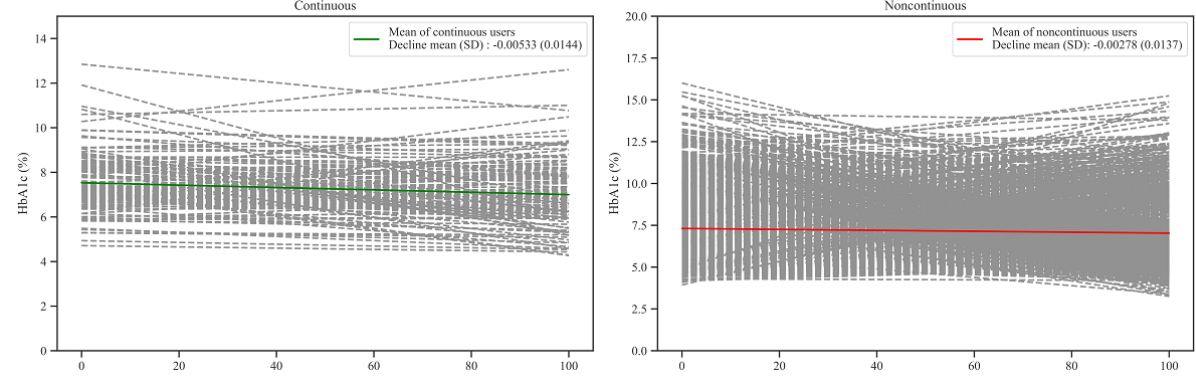
Figure 3. Hemoglobin A 1c (HbA 1c ) patterns (decline, r-squared value, and SD) of continuous and noncontinuous users. The x-axis is the percentage of days past from the first HbA 1c measurement compared with the period between the first and last HbA 1c measurements. The dashed lines are the HbA 1c decline of each patient. The slope and y-axis intercept of the continuous lines indicates the mean of slope and y-axis of patients, respectively.